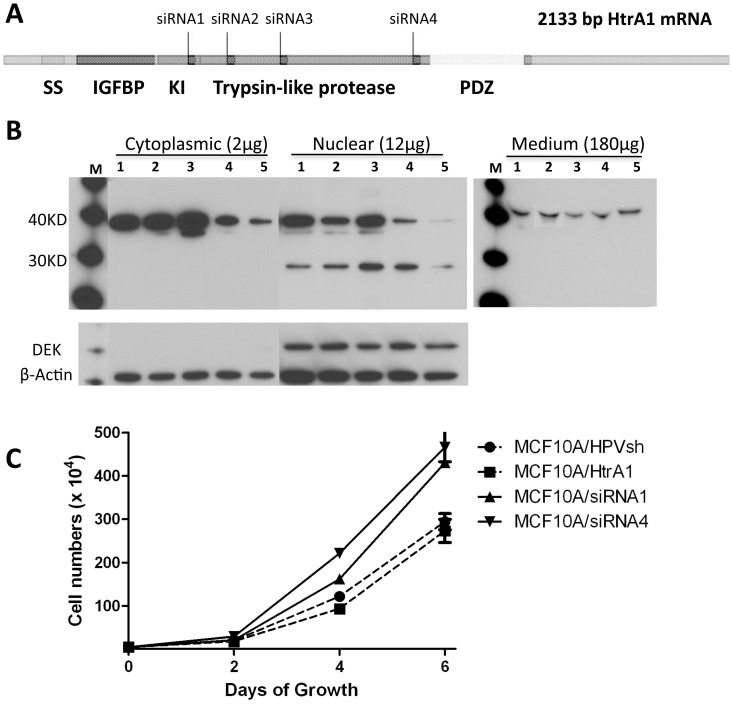
Characterization of MCF10A cell lines carrying HtrA1 siRNA and overexpression vectors.A random antisense oligonucleotide library was used to identify optimally accessible sites in HtrA1 mRNA. SiRNAs (short hairpin RNAs) were designed to target these sites, and stably transfected cell lines were developed from MCF10A cells (4 independent cell lines, designated MCF10A/siRNA1-4). A control cell line expressing an irrelevant siRNA (designated MCF10A/HPVsh) was also developed. In parallel, we also developed a cell line over-expressing HtrA1 (designated MCF10A/HtrA1). (A). Target sites empirically identified in HtrA1 mRNA. Identified domains within HtrA1 include: SS, signal sequence; IGFBP, IGF binding site; KI, Kazal Type I protease inhibitor domain; Trypsin-like protease domain; PDZ, PDZ binding domain. (B) Immunoblot analysis for HtrA1 protein. Cytoplasmic and nuclear protein fractions were prepared from the developed cell lines (as indicated), and were probed with a polyclonal antibody preparation directed against a region in the trypsin-like protease domain. As is evident, the reductions in HtrA1 protein levels were >90% compared with the various MCF10A and MCF10A/HPVsh cells. Right panel shows HtrA1 in concentrated culture medium. (C) Cells were plated and growth was measured over a 6 day period. Both of the MCF10A cell lines tested (MCF10A/siRNA1 and siRNA4) grew significantly faster than the control cells (p<0.01 at days 4 and 6). Over-expression of HtrA1 in the MCF10A/HtrA1 cells had no effect on cell growth rate.